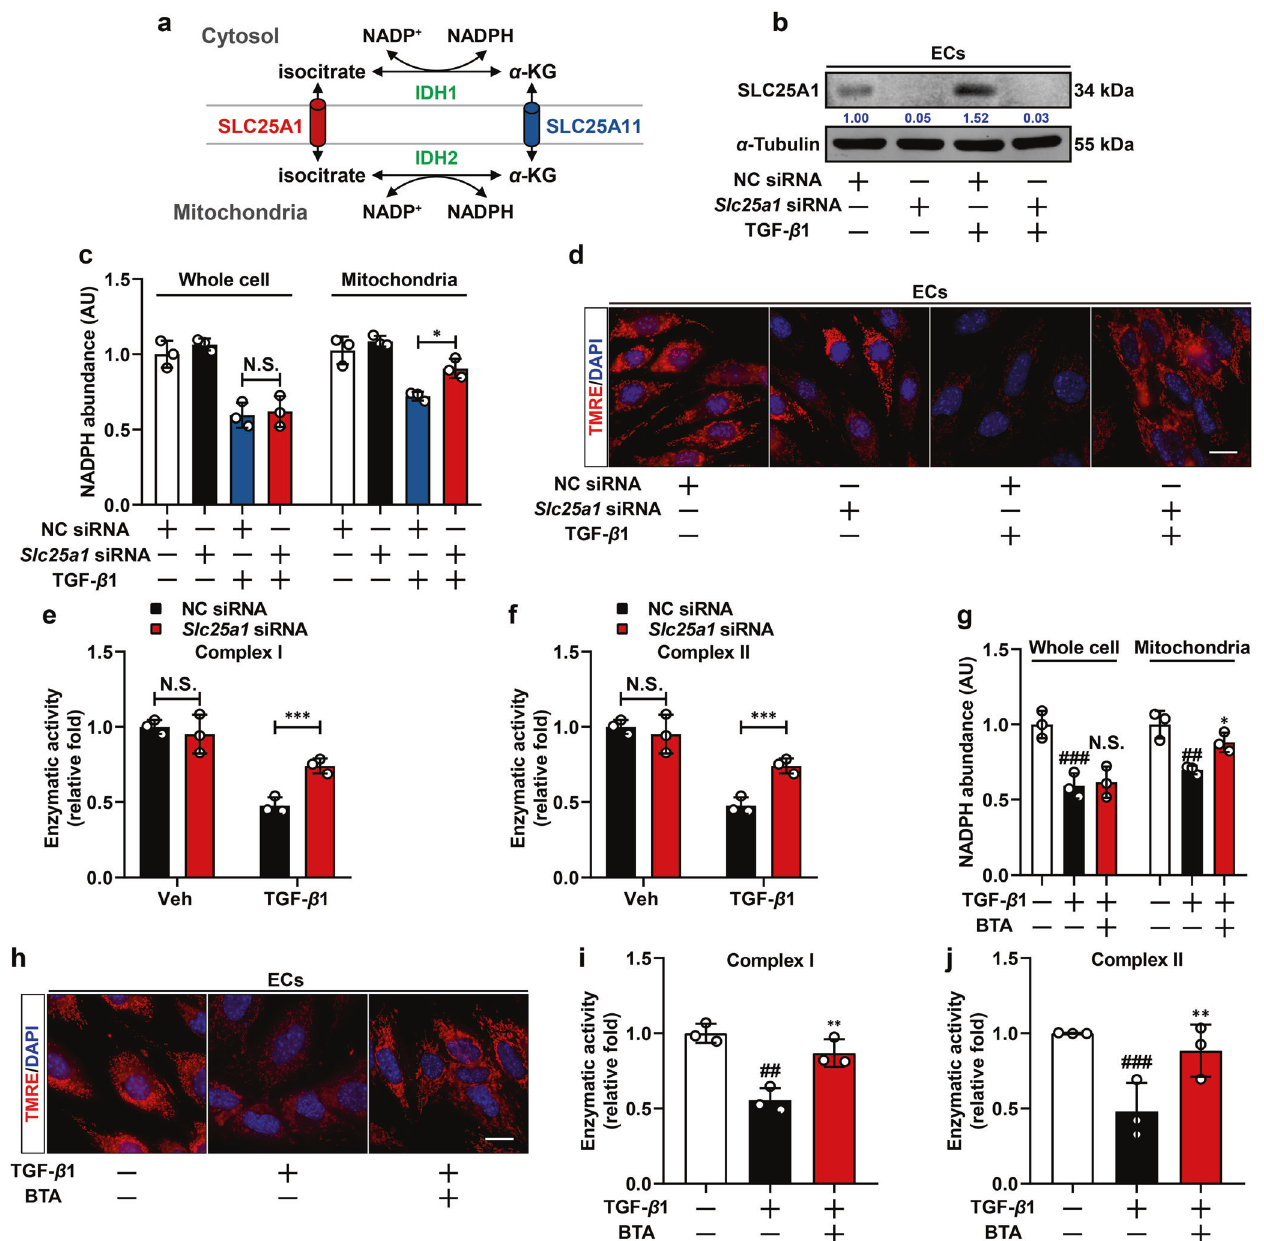
Fig. 7 Realignment of intracellular NADPH distribution through isocitrate/ α -ketoglutarate ( α -KG) shuttle compromises OxPhos activity. a Schematic of isocitrate/ α -KG shuttle machinery in connecting cytosolic and mitochondrial NADPH pool. b Immunoblot analysis of SLC25A1 expression in negative control (NC) or Slc25a1 siRNA transfected ECs following vehicle, TGF- β 1 or SAC treatment. α -Tubulin was used as the loading control ( n = 3). c Relative NADPH abundance in whole-cell and mitochondrial fractions in NC siRNA or Slc25a1 siRNA transfected ECs post vehicle or TGF- β 1 treatment ( n = 3). d Fluorescent staining of TMRE in NC siRNA or Slc25a1 siRNA transfected ECs post vehicle or TGF- β 1 treatment, scale bar, 20 μ m ( n = 3). e , f Relative complex I and complex II activity in NC siRNA or Slc25a1 siRNA transfected ECs post vehicle or TGF- β 1 treatment ( n = 3). g Relative NADPH abundance in whole-cell and mitochondrial fractions in quiescent, transformed, and 1, 2, 3-benzenetricarboxylic acid hydrate (BTA)-treated ECs ( n = 3). h Fluorescent staining of TMRE in quiescent, transformed, and BTA-treated ECs, scale bar, 20 μ m ( n = 3). i , j Relative complex I and complex II enzymatic activity in quiescent, transformed, and BTA-treated ECs ( n = 3). Data are represented as mean ± SD. ## p < 0.01, ### p < 0.001 versus control group. * p < 0.05, ** p < 0.01, *** p < 0.001, N.S., nonsigni fi cant versus model group ( g , i , j ) or indicated A balanced glycolytic/oxidative metabolism is essential for ECs to mitochondrial oxidation via blunting functions of mitochondrial Fe- maintain phenotypic and functional homeostasis, although glyco- S cluster proteins. By impairing PFKFB3 protein stability, SAC lysis is considered as a major source of energy at quiescent state. In restrains glycolysis to ensure PPP-derived NADPH production, and our study, greater dependence on aerobic glycolysis is observed in thus preserves the functional integrity of mitochondrial Fe-S cluster ECs in the setting of EndoMT. This metabolic shift might be viewed proteins by maintaining mitochondrial NADPH homeostasis, con- as an adaptive response to the phenotypic alternation, since rapidly tributing to amelioration of EndoMT and cardiac fi brosis.